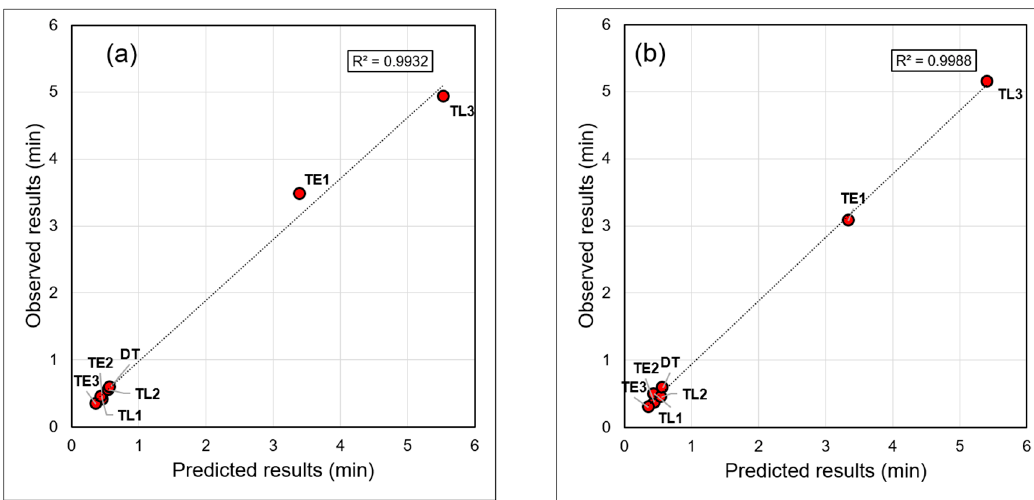
Figure 7. Results of correlation analysis between the predicted and observed mean truck travel times derived from the haulage operation results performed on (a) 2019-01-02 and (b) 2019-01-09.